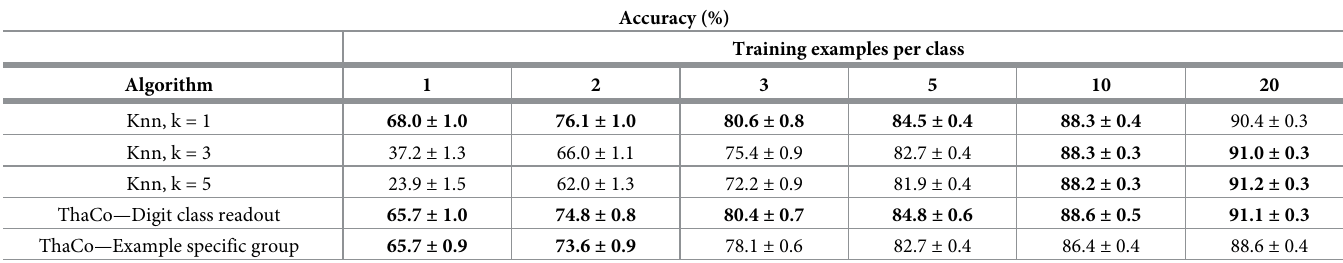
Table 1. Accuracy achieved by the different learning algorithms over a different number of training examples. The accuracy has been computed over a test set of 500 examples, and the average is done over 20